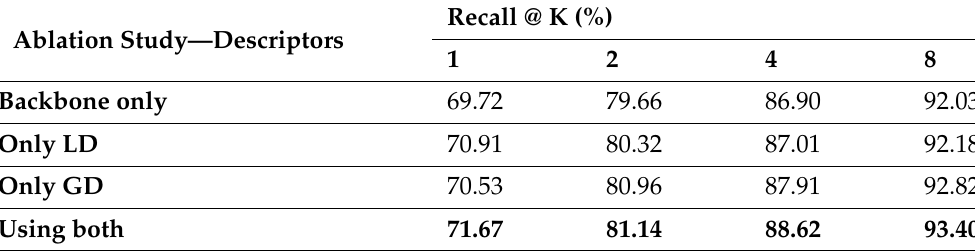
Table 4. Ablation study—the effect of descriptors. The bold values are the best performances in each recall @ K.